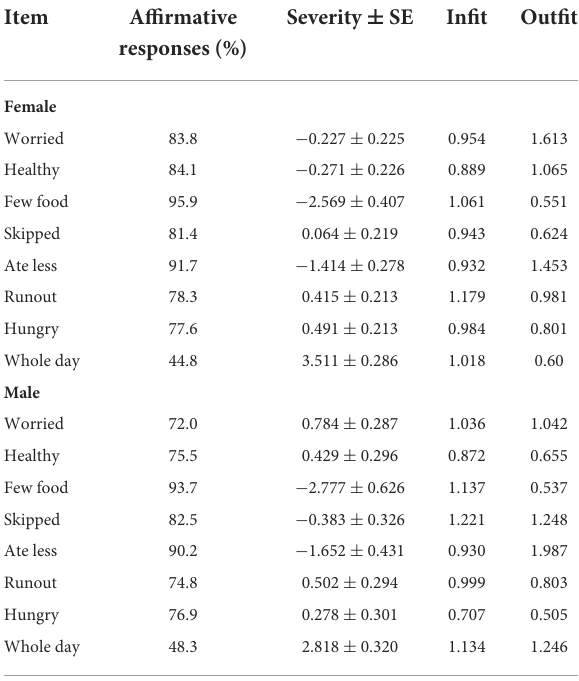
TABLE 6 Proportion of affirmative responses to FIES items, item severity parameters and item fit statistics, grouped by sex.